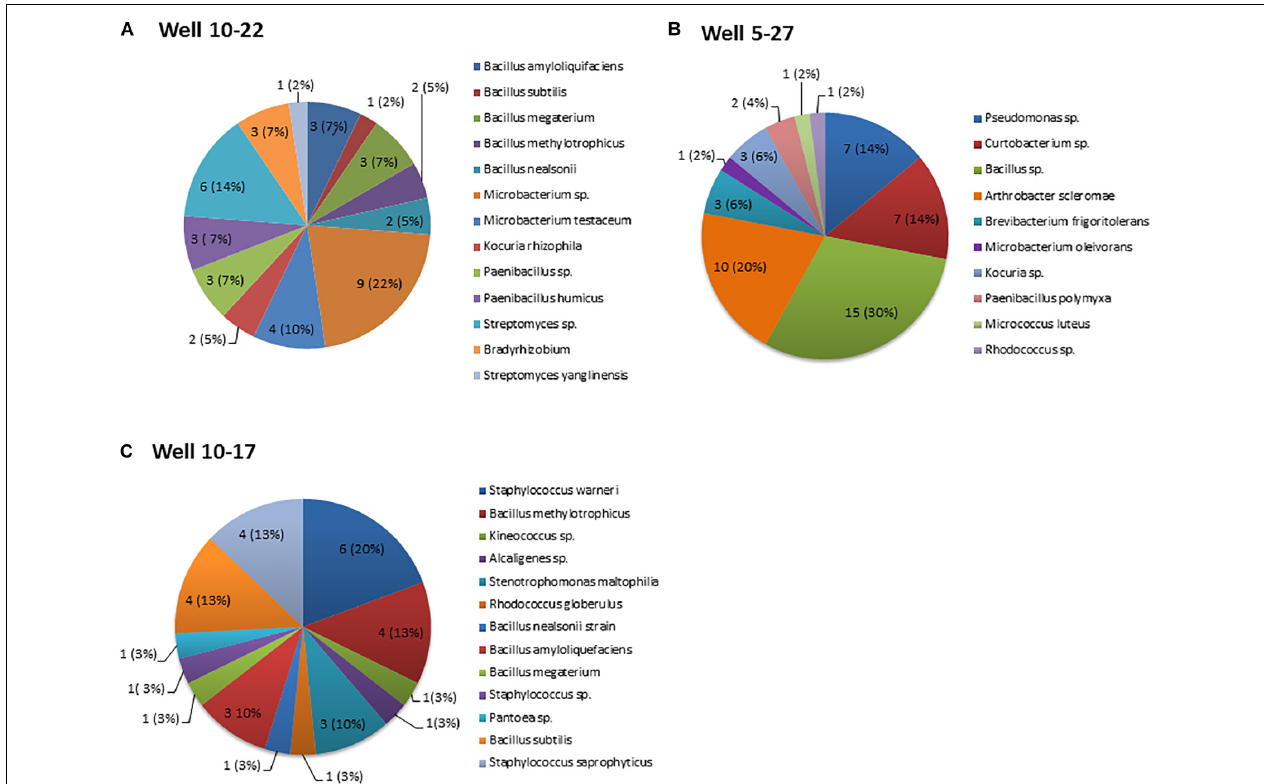
FIGURE 1 | Distribution of bacterial genera recovered from the three oil wells. The numbers in each pie chart represent the isolates of each genus. The numbers in brackets represent the abundance of bacterial isolates of each genus relative to the total number of isolates recovered from each oil well. (A) Well 10–22, (B) Well 5-27, and (C) Well10-17. Data represent the average of three-replicate